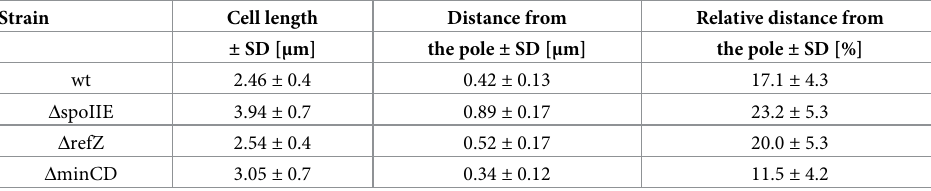
Table 1. Summary of sporulation septa position in wild type and mutant strains. Strain Cell length Distance